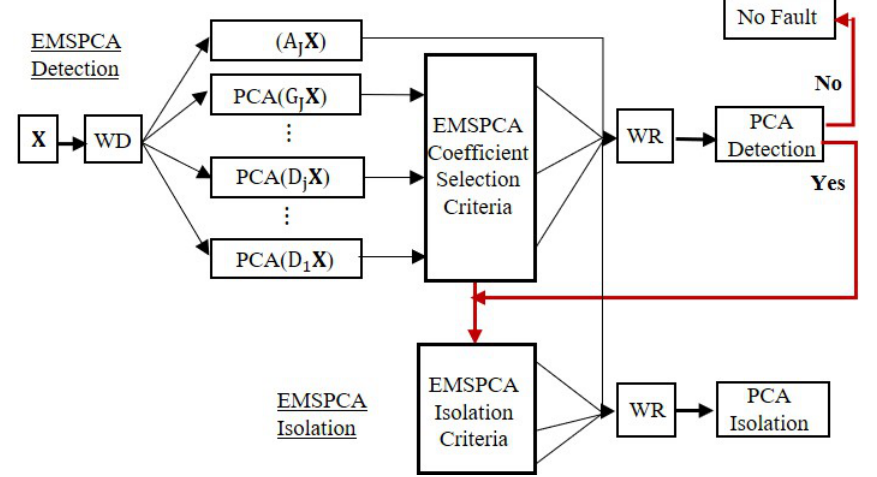
Figure 5. EMSPCA fault detection and isolation algorithm flow